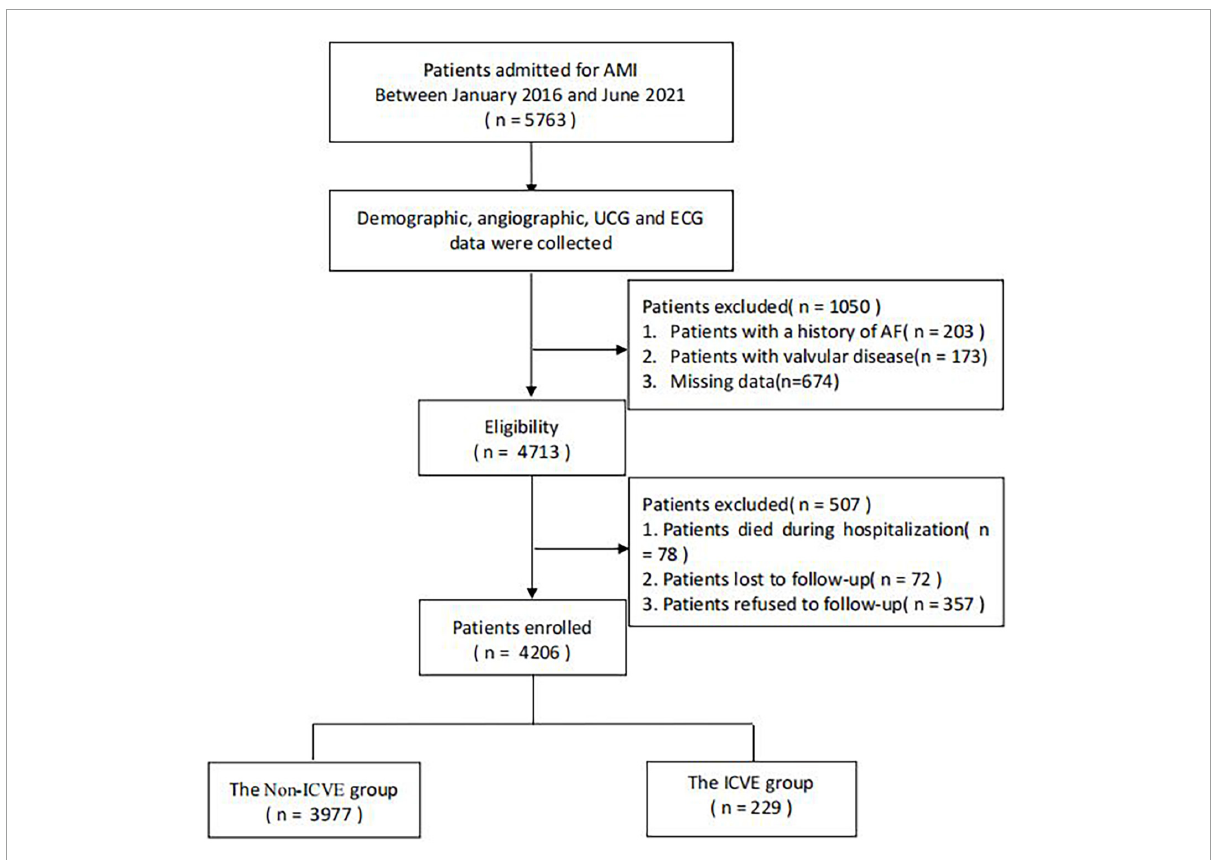
FIGURE1 The overview of the selection of study participants. AF, atrial fibrillation; AMI, acute myocardial infarction; ECG, electrocardiogram; ICVE, ischemic cerebrovascular events; UCG, ultrasound cardiogram.